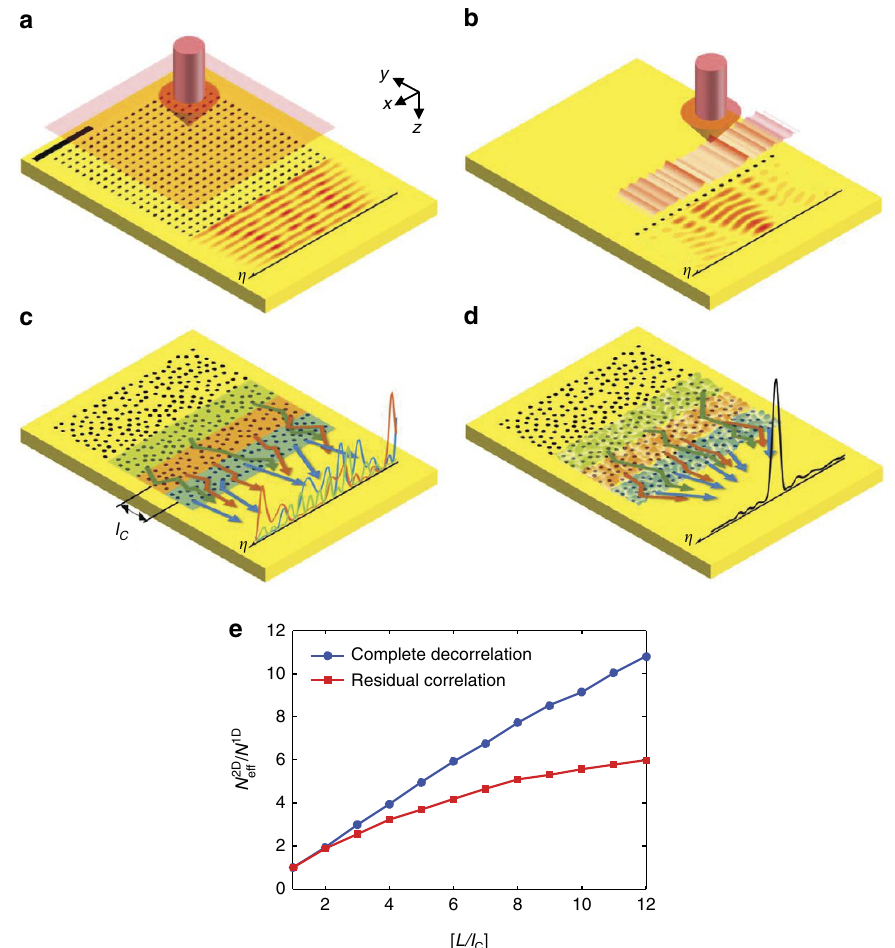
Figure 1 | Numerical and theoretical analyses describing the performance of a 2D disordered array of nanoholes in channel transfer. ( a ) A 2D array of periodic nanoholes patterned on a metal film. Black dots indicate the positions of the holes. SPPs generated by a normally incident plane wave propagates along y- direction. Scale bar, 2 m m. ( b ) A 1D array of nanoholes patterned on a metal film. The incident wave whose wavefront is properly shaped focuses the SPPs generated at the nanoholes at a target spot on a sampling line ( Z ). ( c ) A 2D array of disordered nanoholes patterned on a metal film. Ordinary planar incident waves generate speckled SPPs. The blue, red and green curves at the sampling line are the SPP fields originating from the representative far-field illumination of the blue, red and green rectangular areas, respectively. The wavelength of the light source was 620nm. The SPPs were uncorrelated if the centre-to-centre distance between two neighbouring illuminations was larger than the characteristic length l c described in the main text. ( d ) The same pattern of nanoholes as ( c ), but the correct choice of wavefront for the illuminations at the blue, red and green rectangular areas can cause the SPPs to constructively interfere at the target point (black curve). All the results displayed here were derived from the numerical simulations using the finite- difference time-domain (FDTD) method (see Supplementary Note 1 for details). ( e ) Expected enhancement factor for channel number a ¼ N 2D respect to the number of effective slabs m ¼ [ L / l c ] (blue dots). The red dots were the enhancement factor predicted after accounting for the residual correlations shown in Fig. 4d (see Supplementary Note